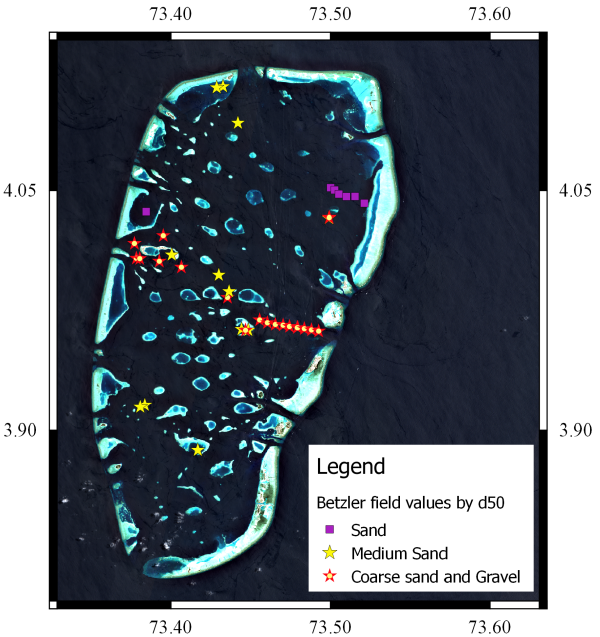
Figure 2. d 50 values for field data obtained by Betzler et al. (2016) laid over Sentinel-2 satellite imagery of South Malé atoll, binned according to grain size